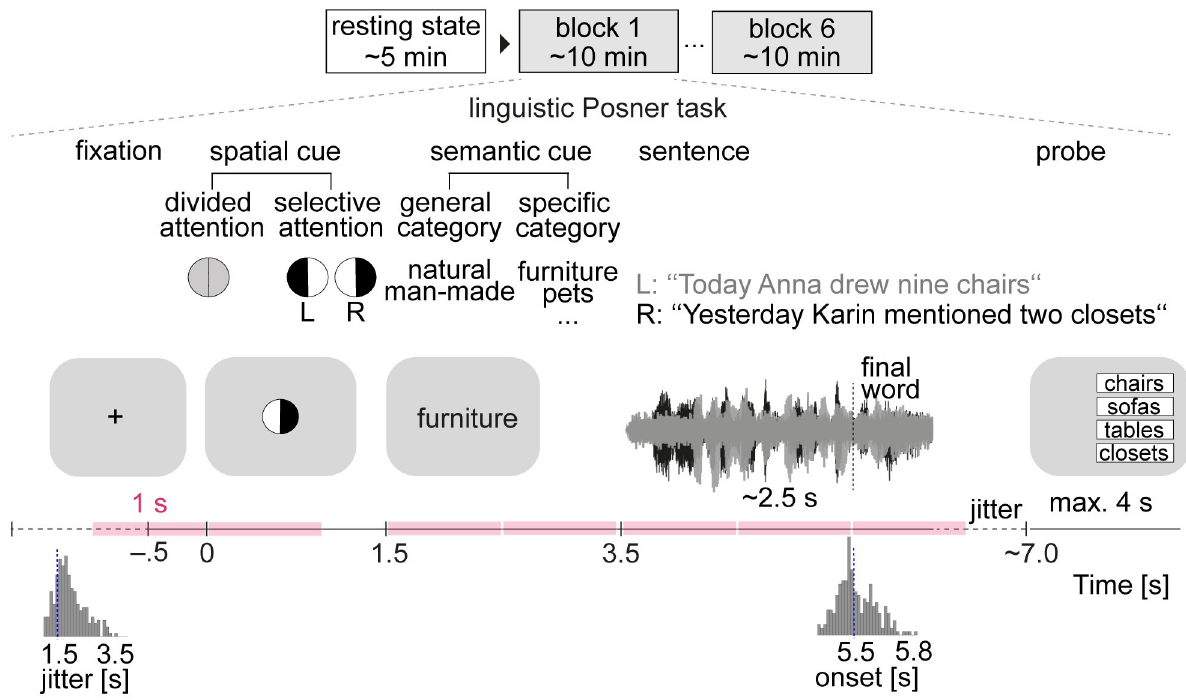
Fig 1. Experimental procedure and the listening task. EEG of N = 154 participants was recorded during a 5-min eyes-open resting state and 6 blocks of a linguistic Posner task with concurrent speech [5]. Participants listened to 2 competing, dichotically presented sentences. Each trial started with the visual presentation of a spatial cue. An informative cue provided information about the side (left ear vs. right ear) of the to-be-probed final word. An uninformative cue did not provide information about the side of the to-be-probed final word. A semantic cue was visually presented indicating a general or a specific semantic category for both final words. The 2 sentences were presented dichotically along with a visual fixation cross. At the end of each trial, a visual response array appeared on the side of the probed ear with 4 word choices, asking participants to identify the final word of the sentence presented to the respective ear. To capture amplitude-coupling between frequency-specific neural oscillations throughout the listening task, power-envelope correlations between narrow-band EEG source signals were estimated for 1-s time windows of interest (colored intervals) and compared with resting state connectivity at the same frequency. The stimulus materials can be found at https://osf.io/nfv9e/. EEG, electroencephalography.